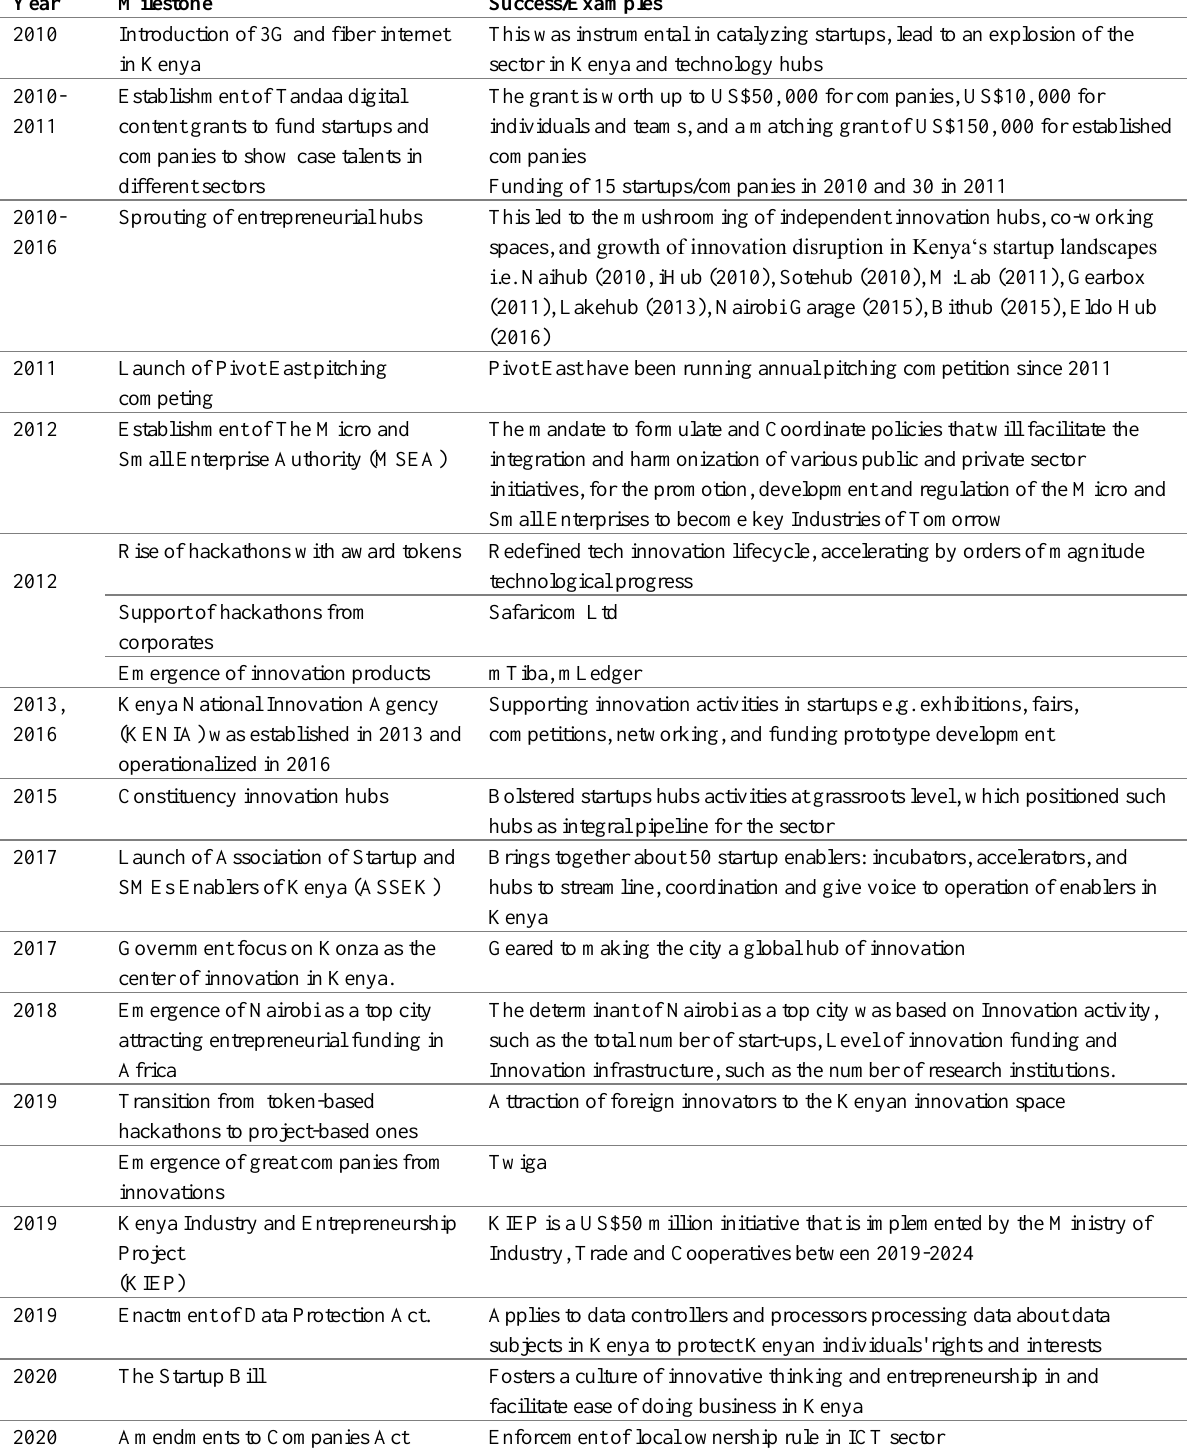
Table 1: Startup Ecosystem Key Milestones over the Last Decade: